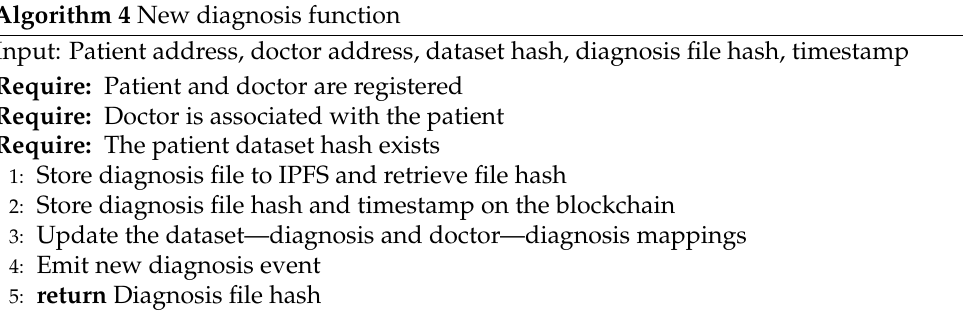
Figure 6. Example of annotations that can be made by the healthcare providers. Algorithm 4 New diagnosis function